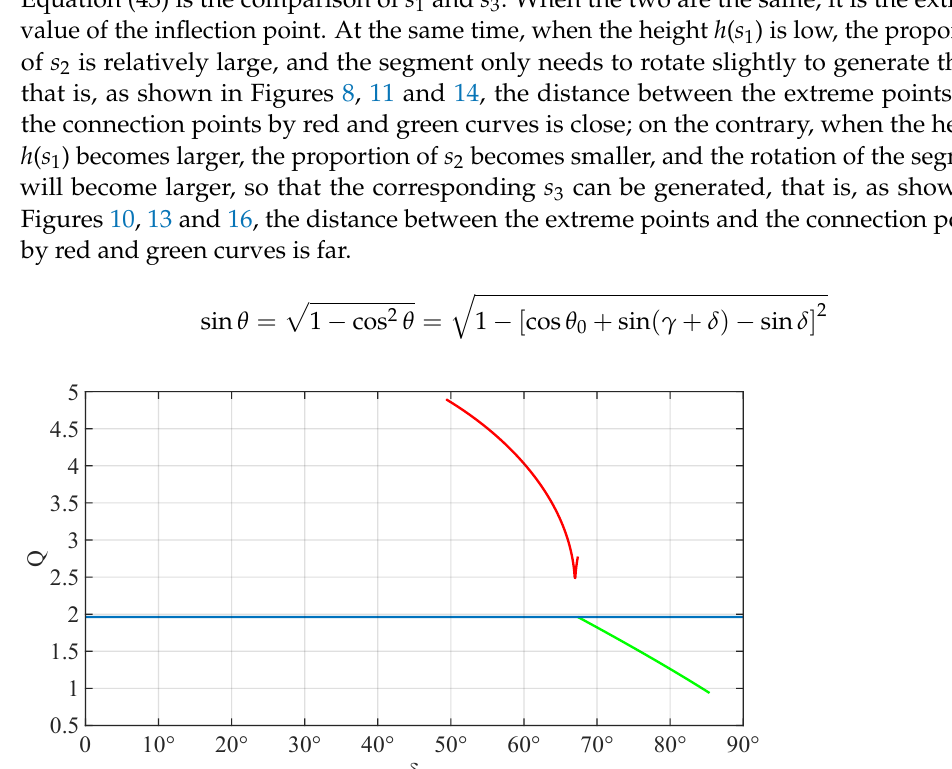
Figure 15. Drive force under transformable state C 1 and C 2 Q (10 mm) (Blue: wheel state; Red: C 1 ; Green: C 2 ). Figure 16. Drive force under transformable state C 1 and C 2 Q (15 mm) (Blue: wheel state; Red: C 1 ; Green: C 2 ).